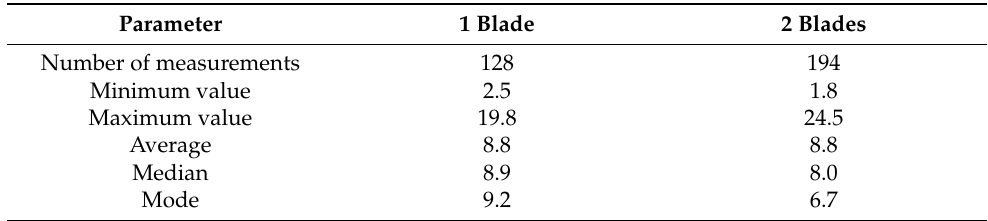
Table 1. Statistics on the ratio of cell width to wall thickness of anilox rollers, grouped by the number of doctor